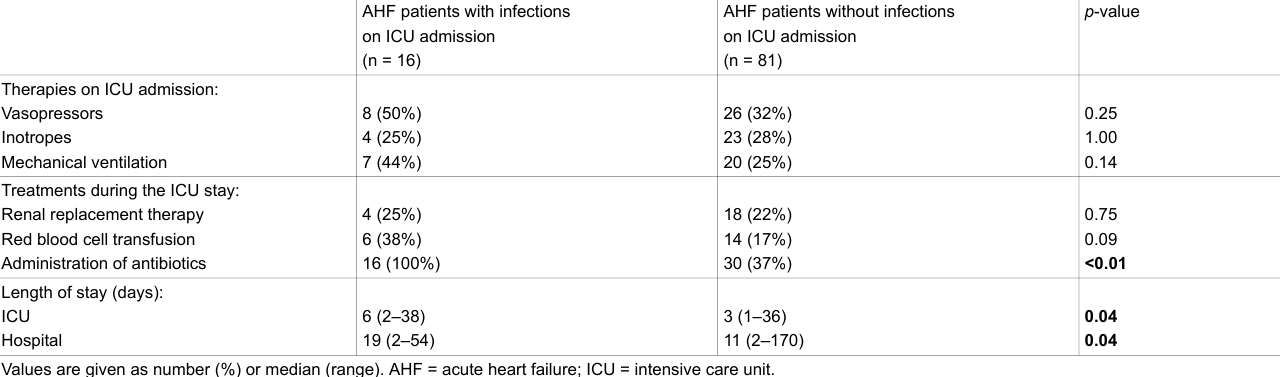
Table 3: Parameters describing the hospital course of acute heart failure patients with and without infections on intensive care unit admission.